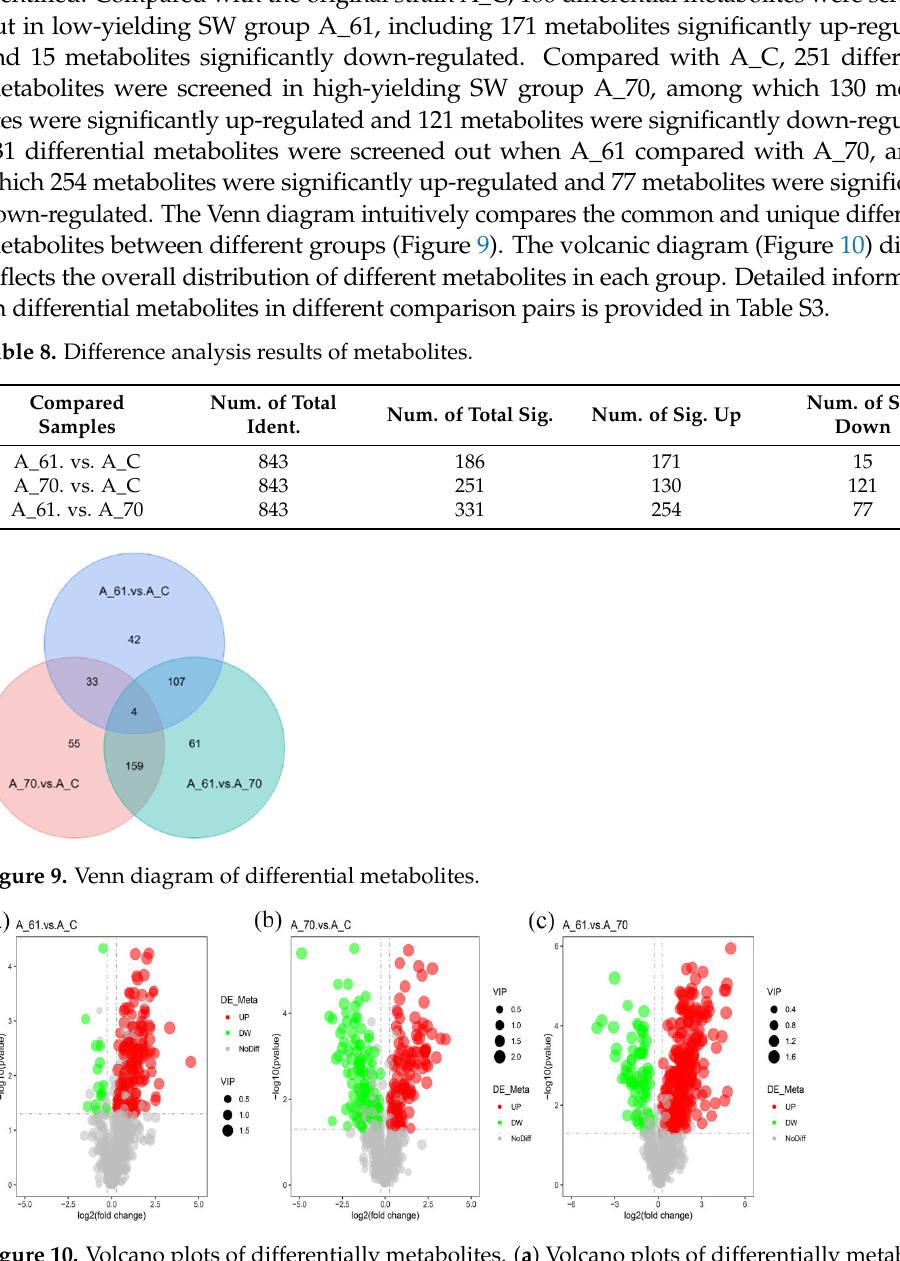
Figure 10. Volcano plots of differentially metabolites. ( a ) Volcano plots of differentially metabolites of mutant 61 and the original strain. ( b ) Volcano plots of differentially metabolites of mutant 70 and the original strain. ( c ) Volcano plots of differentially metabolites of mutant 61 and mutant 70.